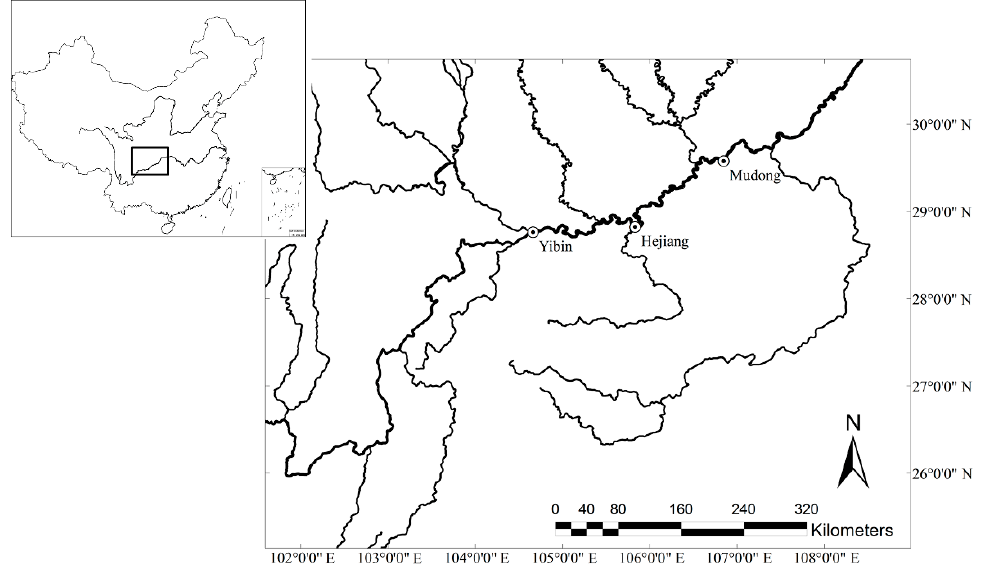
Figure 2. Sampling sites along the upper Yangtze River, China.